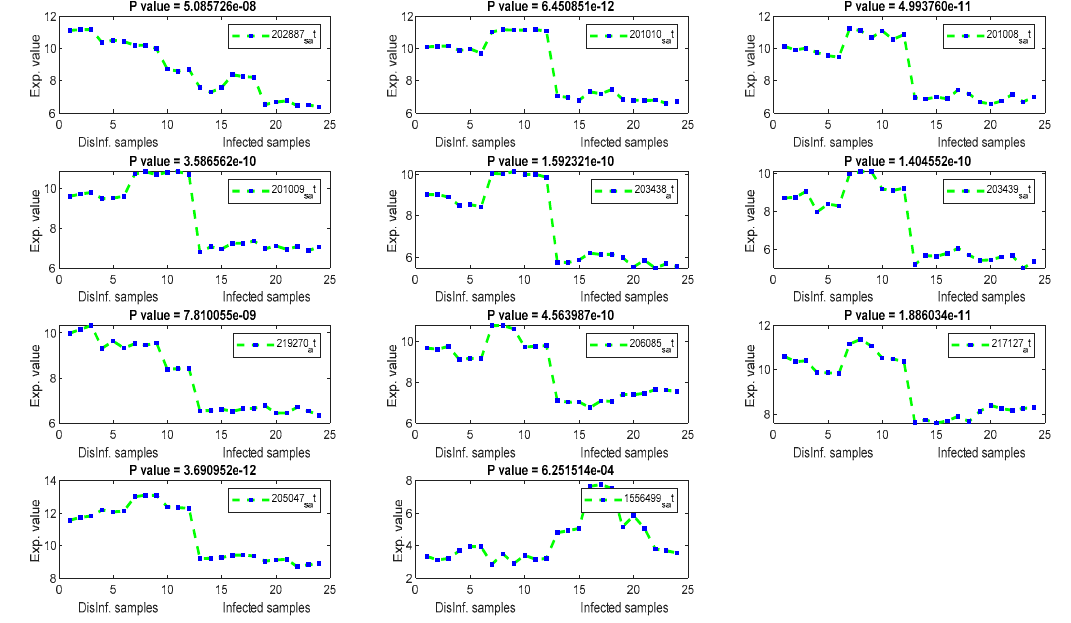
Figure 4. The gene signal profile of top ranked key genes retrieved using T -test and F-test.